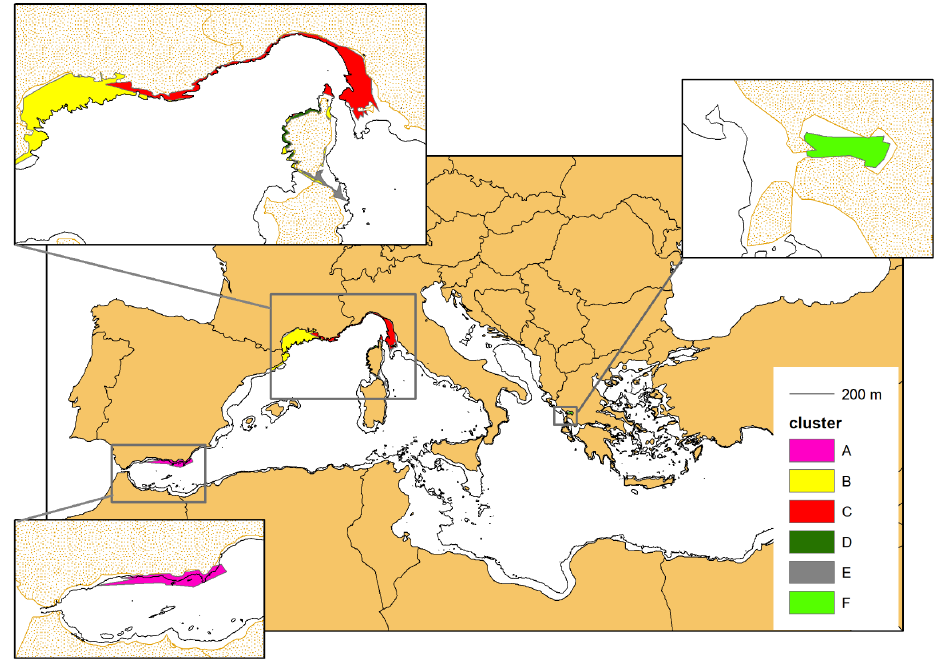
Figure 9. The multi-polygons resulting from the overlap of the single MCPs of the individuals belonging to the same cluster (see Figure 7). The MCPs were cropped following the 200 m isobaths marking the border of the continental shelf, except for cluster A (purple colour), residing in the Alboran Sea (see the main text for further details). Table 4. The average area (km 2 ) of the individual MCP, the area (km 2 ) of the complex MP and the average width of the continental platform (CP) in the area of occupancy of the related cluster (see also Figure 9). We could not calculate the average CP width for the occupancy area of cluster F, as the Gulf of Ambracia is fully included in the continental platform.